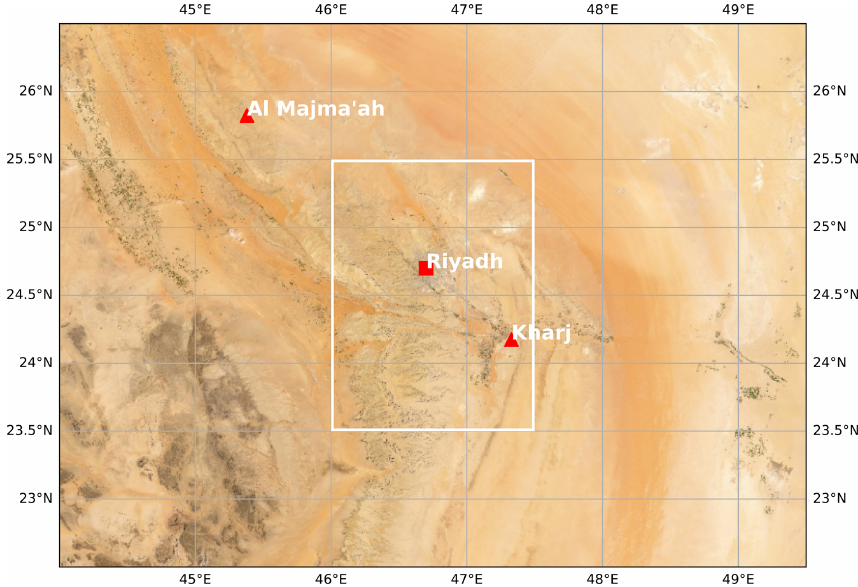
Figure A8. Map of Riyadh (© Esri). The area in the white rectangle represents the study area.